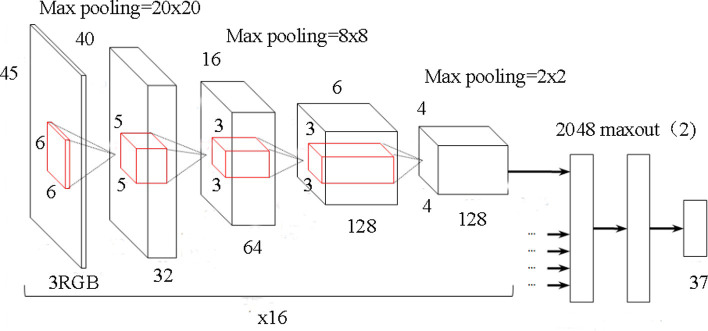
Structure of DNN.